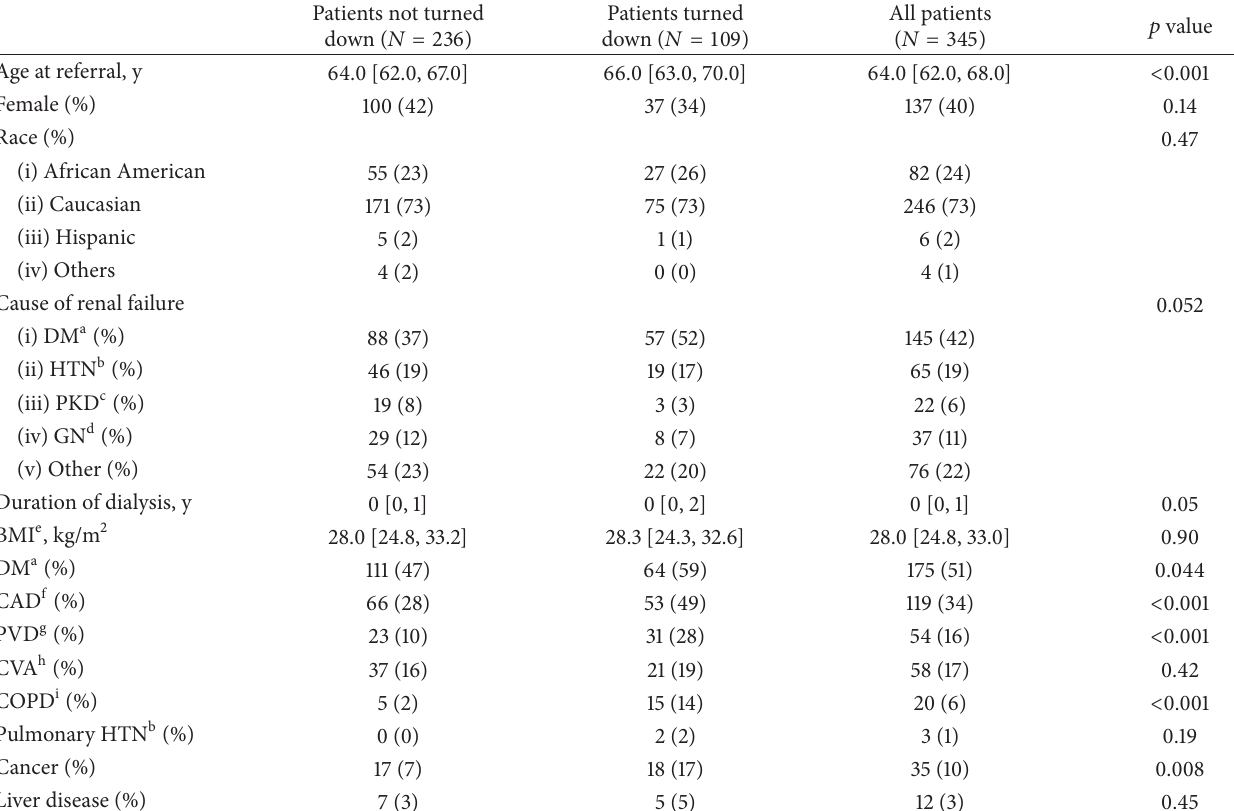
Table 3: Clinical characteristics at time of referral of patients by approval